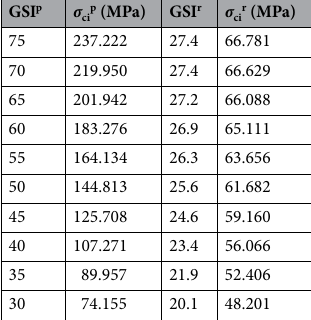
Table 8. Estimated values of σ cip and σ cir